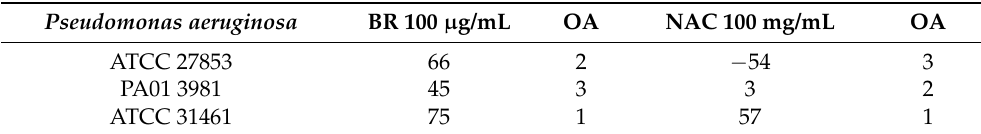
Table 3. Comparison of maximum biofilm dissolution (BD MAX) activity levels of bromelain (BR) and N -acetylcysteine (NAC). OA = order of activity. Note that negative values indicate the synthesis or growth of biofilm.